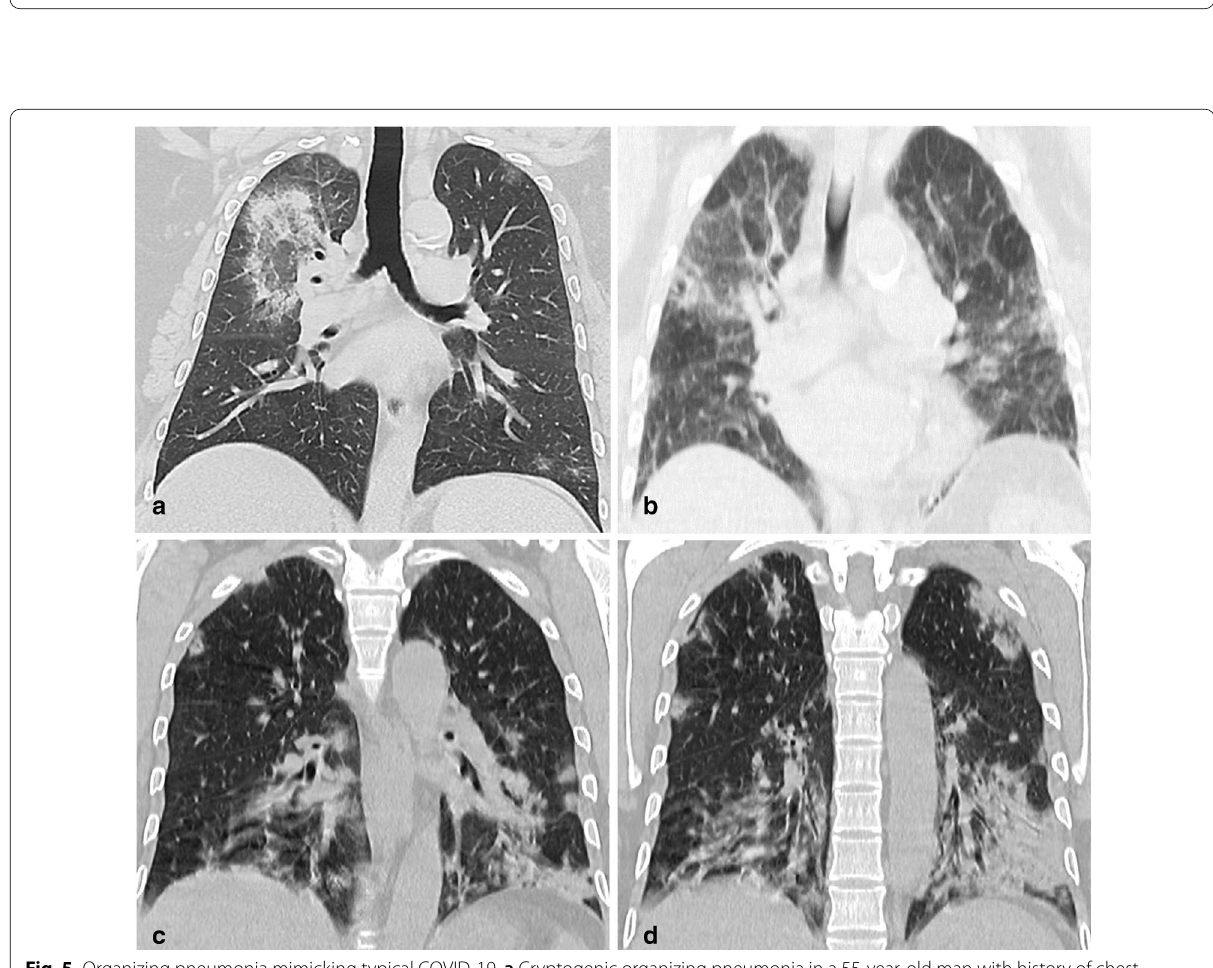
Fig. 5 Organizing pneumonia mimicking typical COVID‑19. a Cryptogenic organizing pneumonia in a 55‑year‑old man with history of chest infection not responding to multiple courses of antibiotics, coronal reformatted CT image shows reversed halo sign in the right lung with small areas of GGO in the left lung. Transbronchial biopsy showed findings of COP. b Rheumatoid arthritis induced interstitial pneumonia in a 67‑year‑old woman, coronal reformatted CT image shows bilateral ground‑glass opacities with interlobular and interstitial thickening. c , d Cyclophosphamide‑induced OP in a 56‑year‑old man with Hodgkin disease, coronal reformatted CT images show peripheral multifocal areas of poorly defined focal consolidation, small areas of GGO and bronchial wall